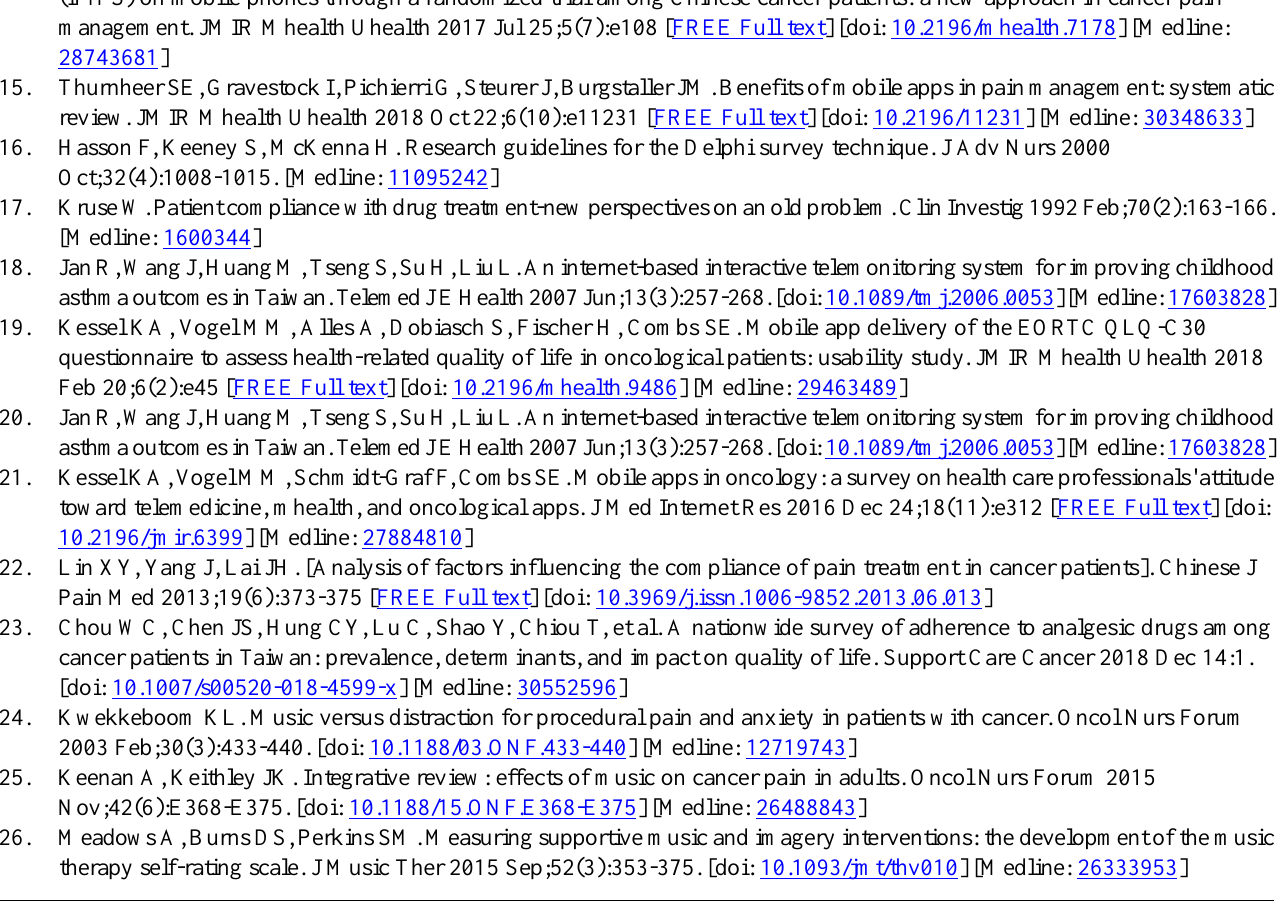
NRS: numerical rating